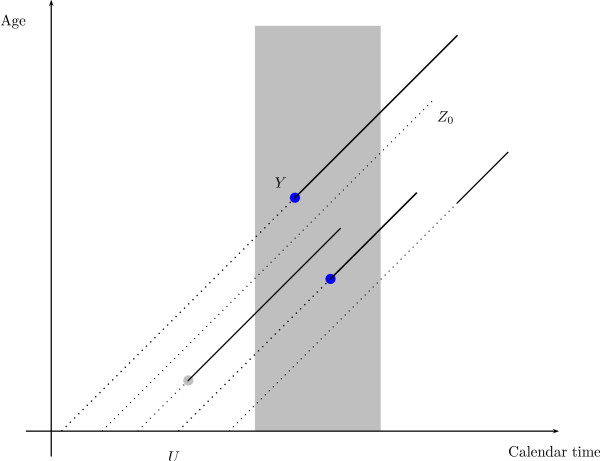
Lexis diagram with observation window (gray area). Dotted lines indicate lifetime without disease until age of onset (Y), or age at death (Z0), full lines lifetime with disease. Only age at onset times within the observation window are observed (blue points) in a cohort-of-cases study.